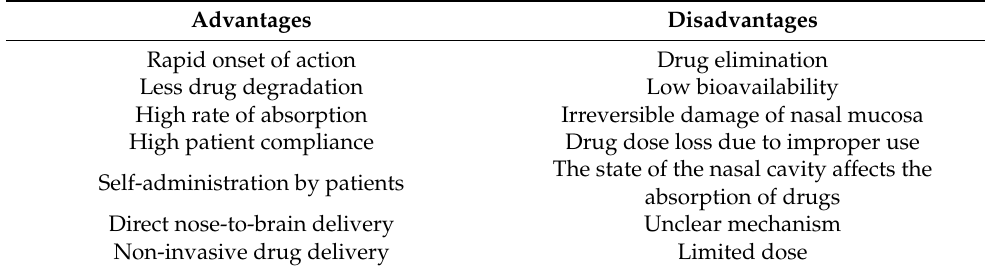
Table 1. Advantages and disadvantages of nasal drug